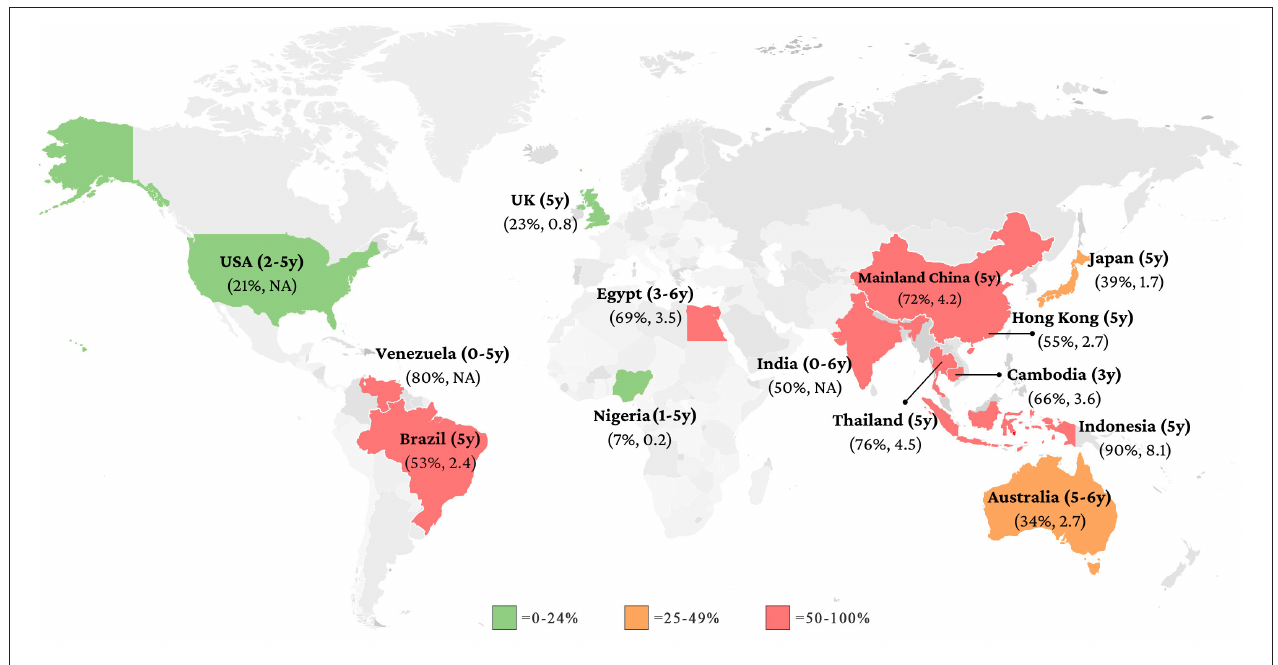
FIGURE 1 | Caries prevalence (%) and caries experience [decayed, missing and filled teeth (dmft) index] of primary teeth in children.